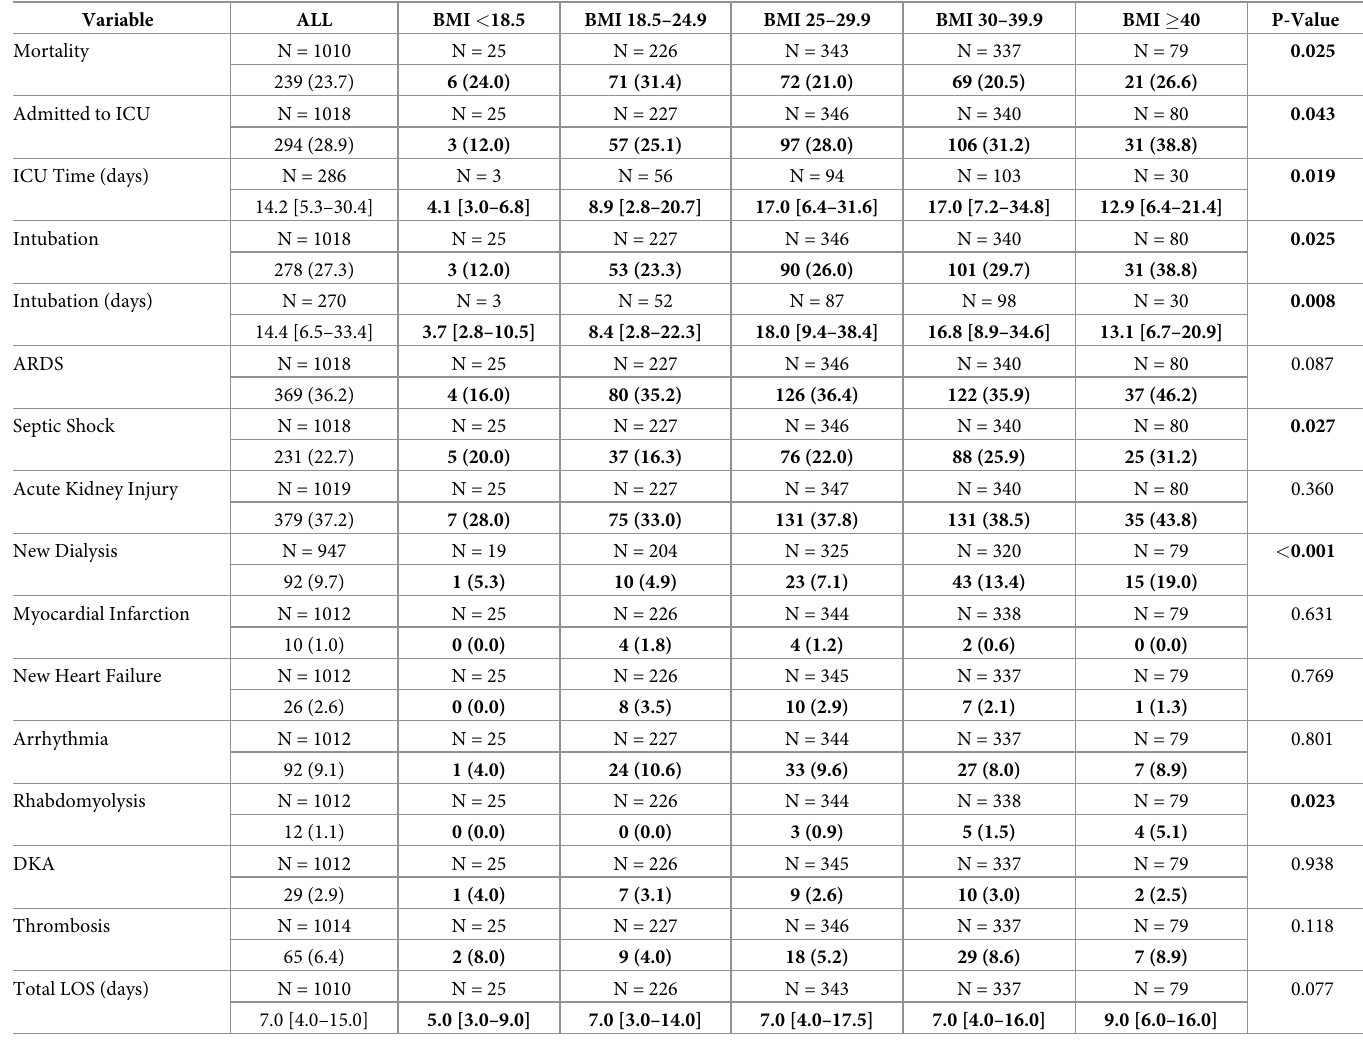
Table 2. Patient outcomes by BMI